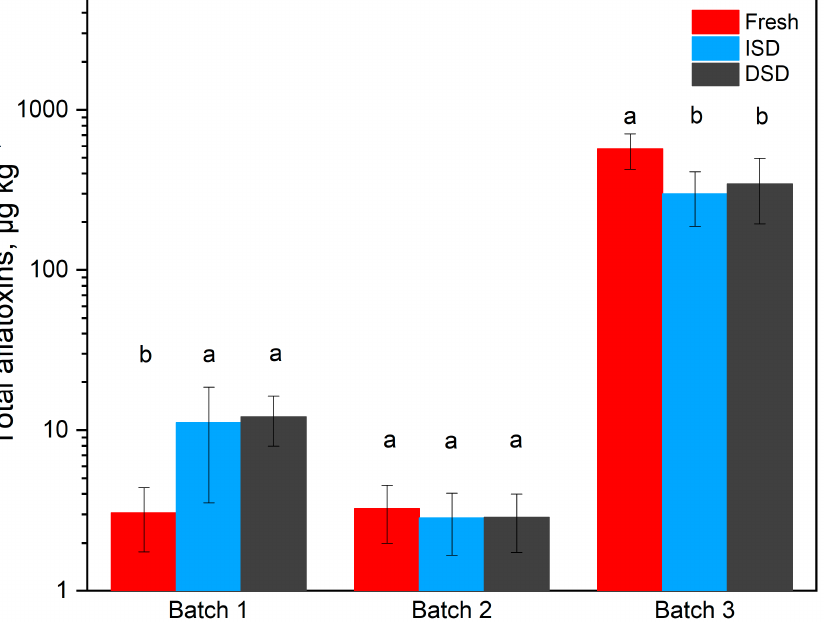
Table 2. Colour parameters of maize dried by ISD compared to DSD (means comparison t -test). L*